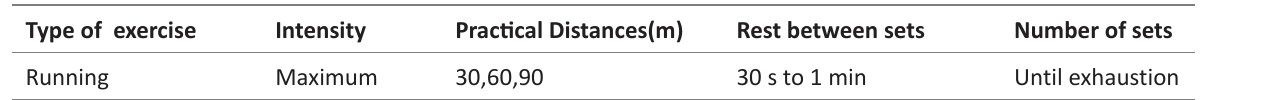
Table 3. A strength circuit training program for one session Type of